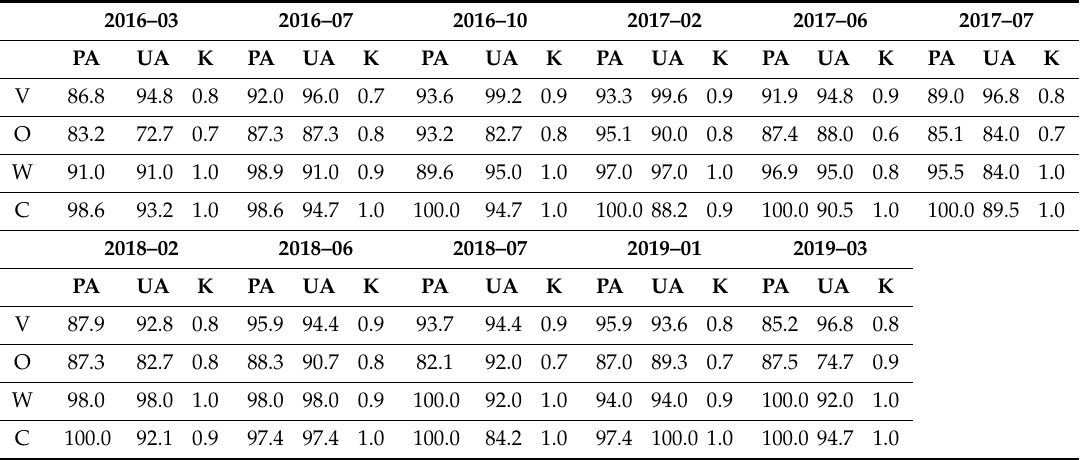
Table 3. Error measures of the land cover